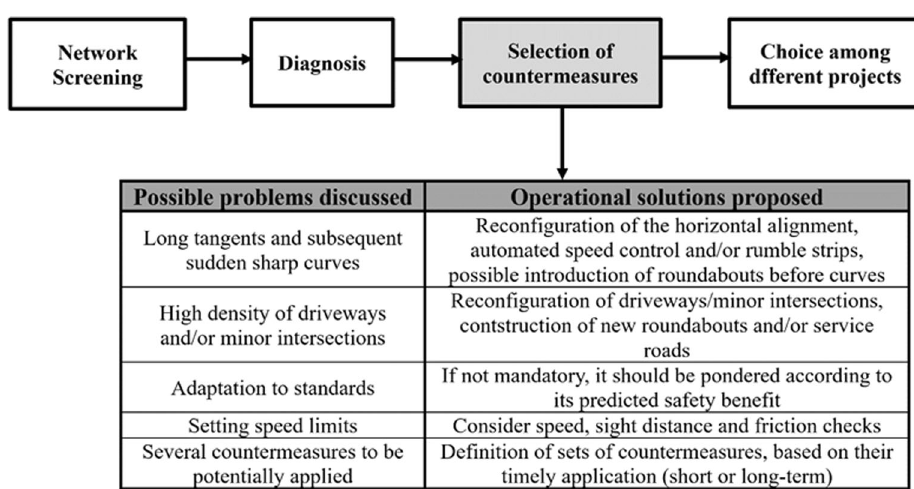
Fig. 9 Selection of